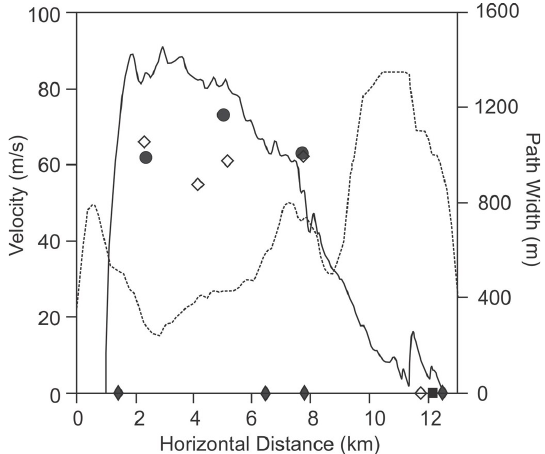
Fig. 11. The plot of frontal velocity versus path distance (solid line) and path width versus path distance (dashed line) for the 2010 Mount Meager landslide. Velocities are compared to estimates from superelevation and run-up data (black dots) and seismic analysis (open diamonds). The black square is actual field run-out and filled black diamonds denote the segments corresponding to the four ma- terials in Table 3.